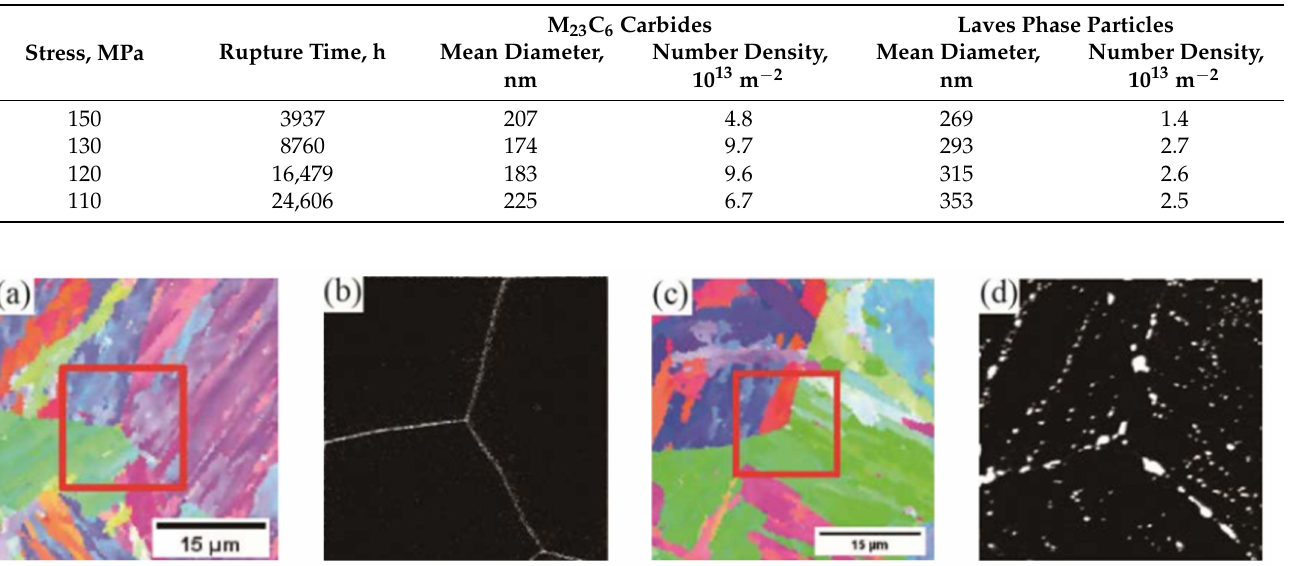
Table 3. Parameters of M 23 C 6 carbides and Laves phase particles in the MARBN steel after creep testing at 650 ◦ C. Data from [27].